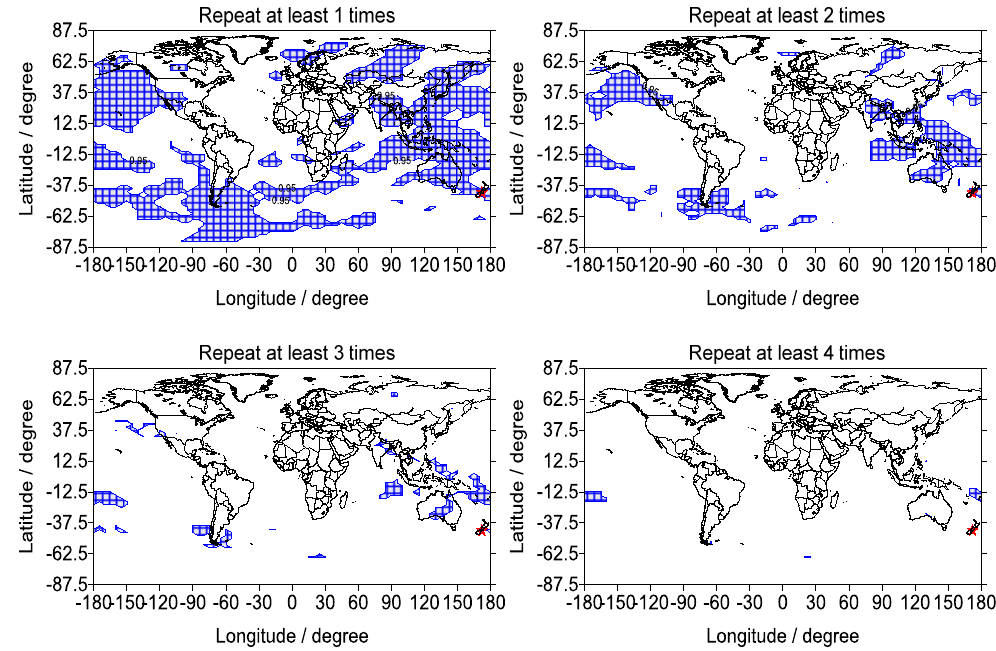
Fig. 14. Locations of the 30-day extreme enhancement that repeatedly appeared at various time points on 2 September 2010.